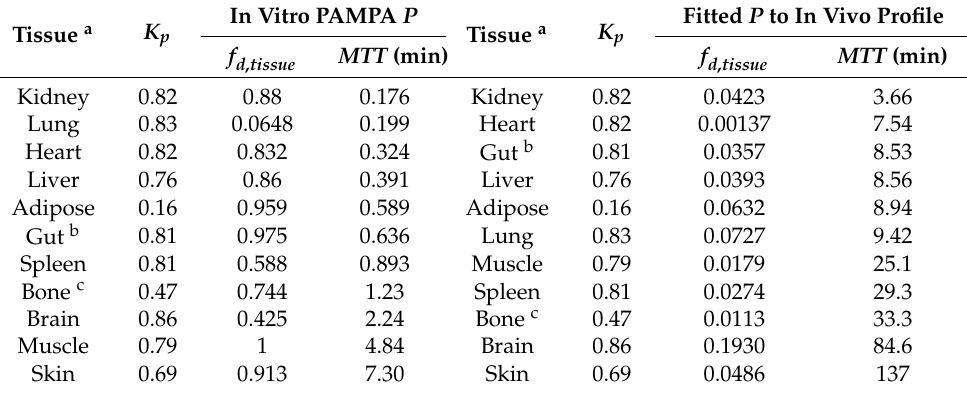
Table 5. A priori in silico calculation of the tissue distribution parameters ( K p and f d ) for 11 typical tissues of rats in the WB-PBPK. The K p values were predicted using the Poulin and Theil [81] and Berezhkovskiy [82] methods built in the GastroPlus PBPK simulator, except for the gut. In vitro PAMPA P (0.5 × 10 − 6 cm/s) and fitted P (0.0102 × 10 − 6 cm/s) were used to calculate the mean transit time ( MTT ). In Vitro PAMPA P Fitted P to In Vivo Profile Tissue a K p Tissue a K p f MTT (min) f MTT d , tissue d , tissue